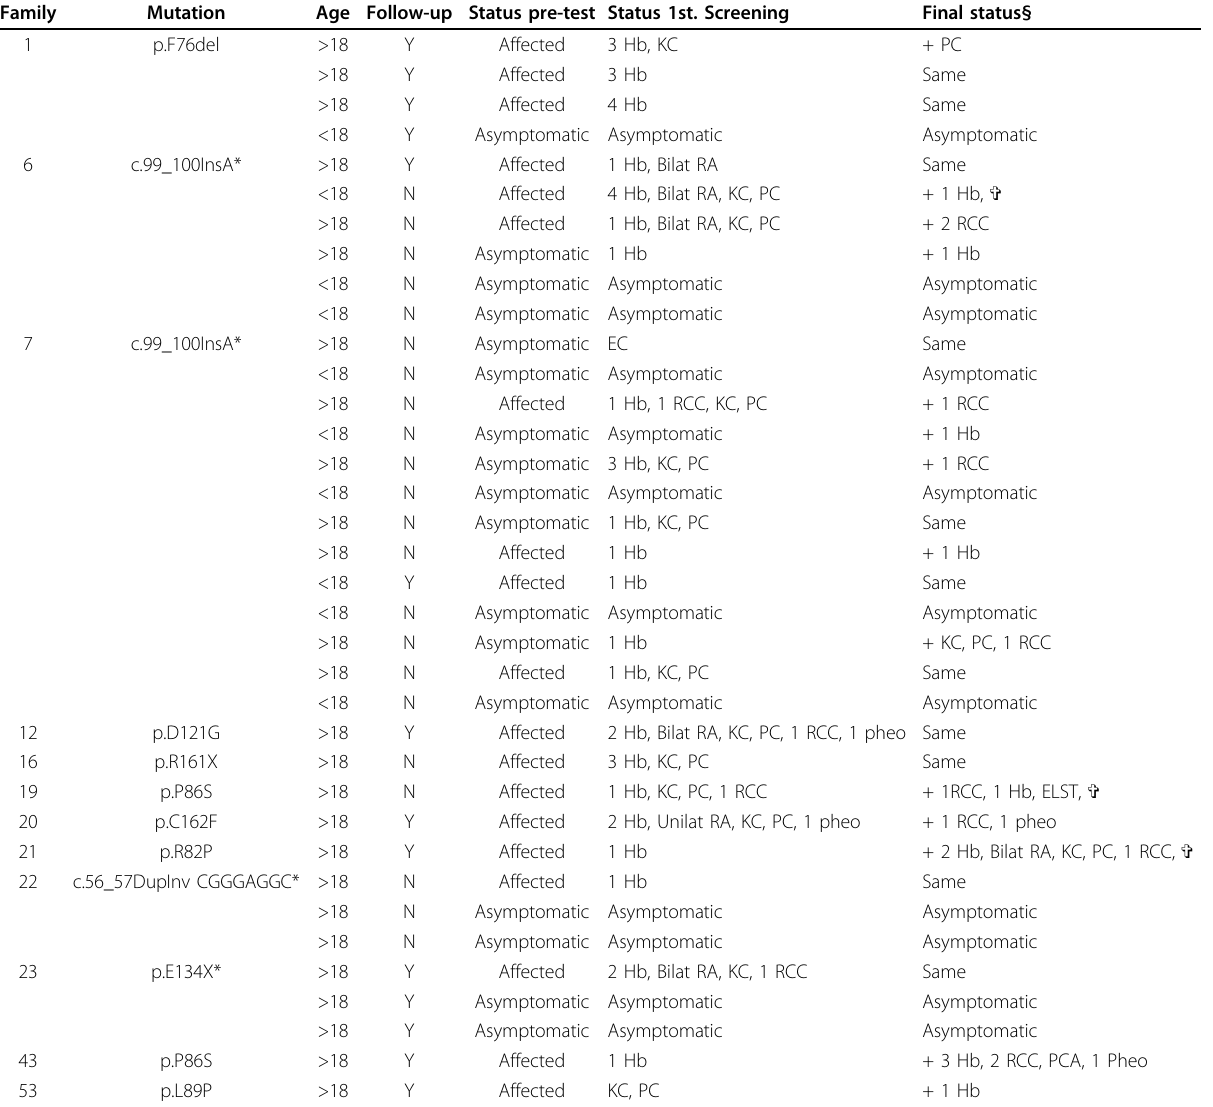
Table 2 Results of genetic testing and tumor surveillance in VHL gene mutation-carriers Family Mutation Age Follow-up Status pre-test Status 1st.